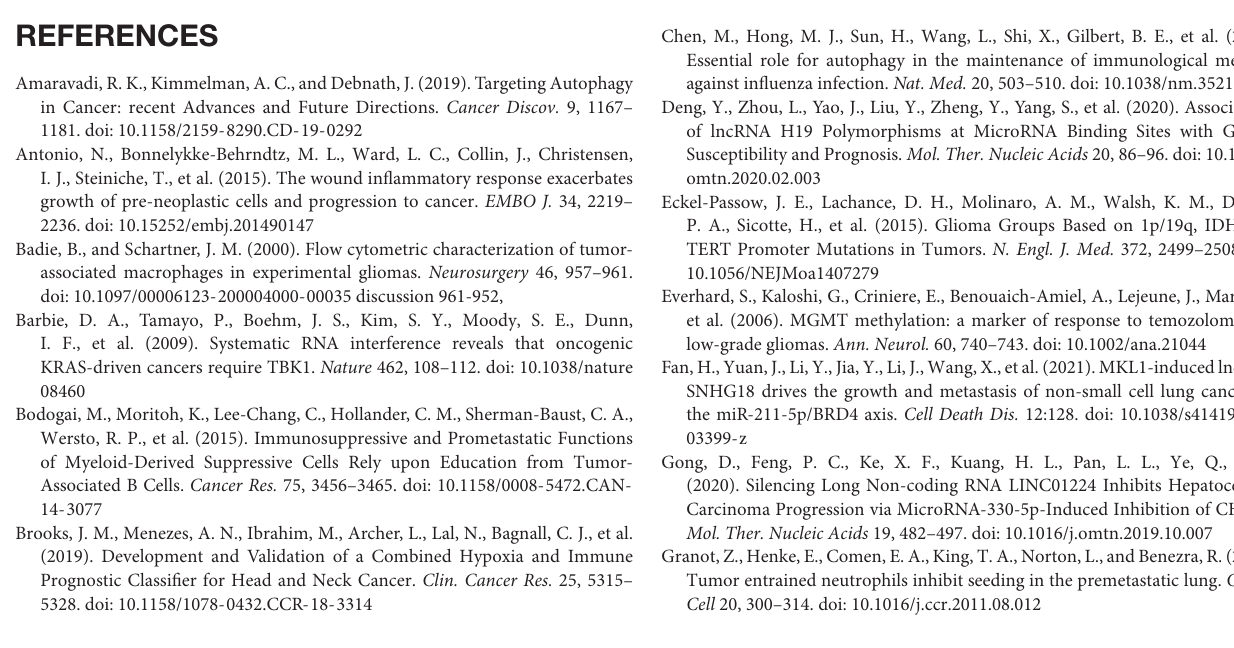
Supplementary Figure 1 | LASSO regression analysis of ARLs in TCGA dataset. Supplementary Figure 2 | Kaplan-Meier analysis of randomly selected eight ARLs in TCGA and CGGA datasets. Supplementary Figure 3 | Volcano plot of differentially expressed genes between cluster 1 and cluster 2 in TCGA and CGGA datasets. Supplementary Figure 4 | PCA analysis of stratification of glioma patients based on ARL score. Supplementary Figure 5 | Time-dependent ROC analysis of different clinical features of